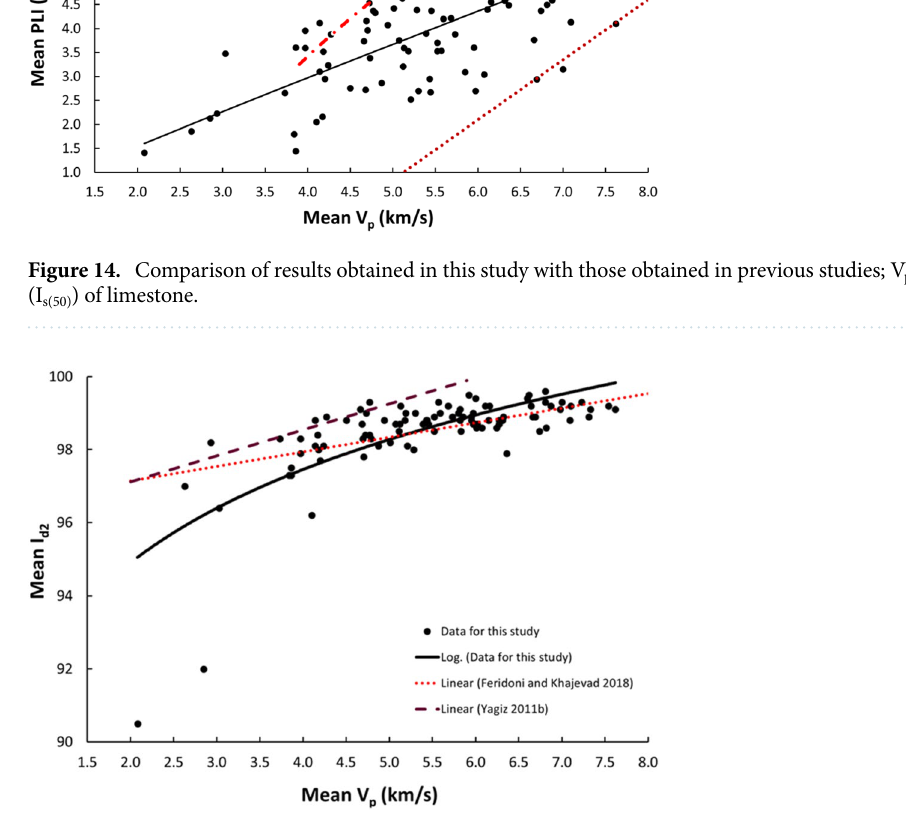
Figure 15. Comparison of results obtained in this study with those obtained in previous studies; V p versus I d2 of